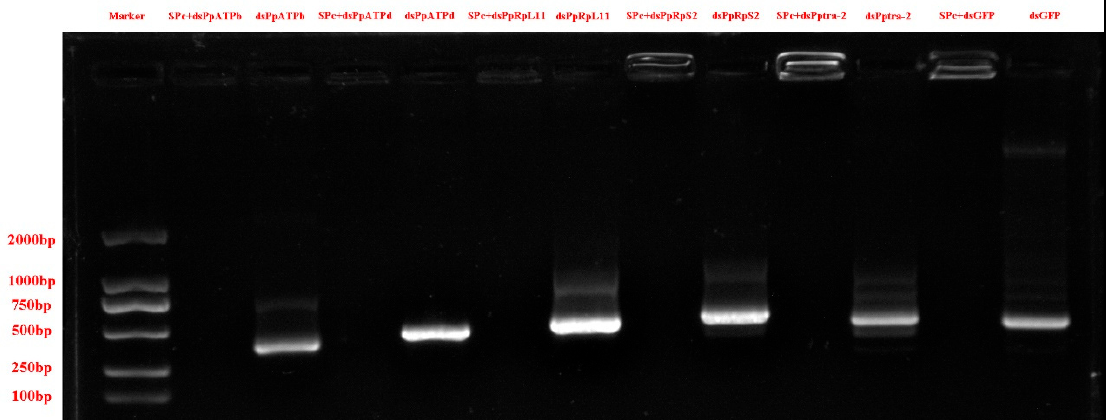
Figure 2. Gel electrophoresis results of SPc mediated dsRNA complexes and corresponding unbound dsRNAs. For each gene, when dsRNA was added, a clear band was observed on the gel. In contrast, no band was observed with dsRNA was mixed with SPc, suggesting that the complex was blocked.